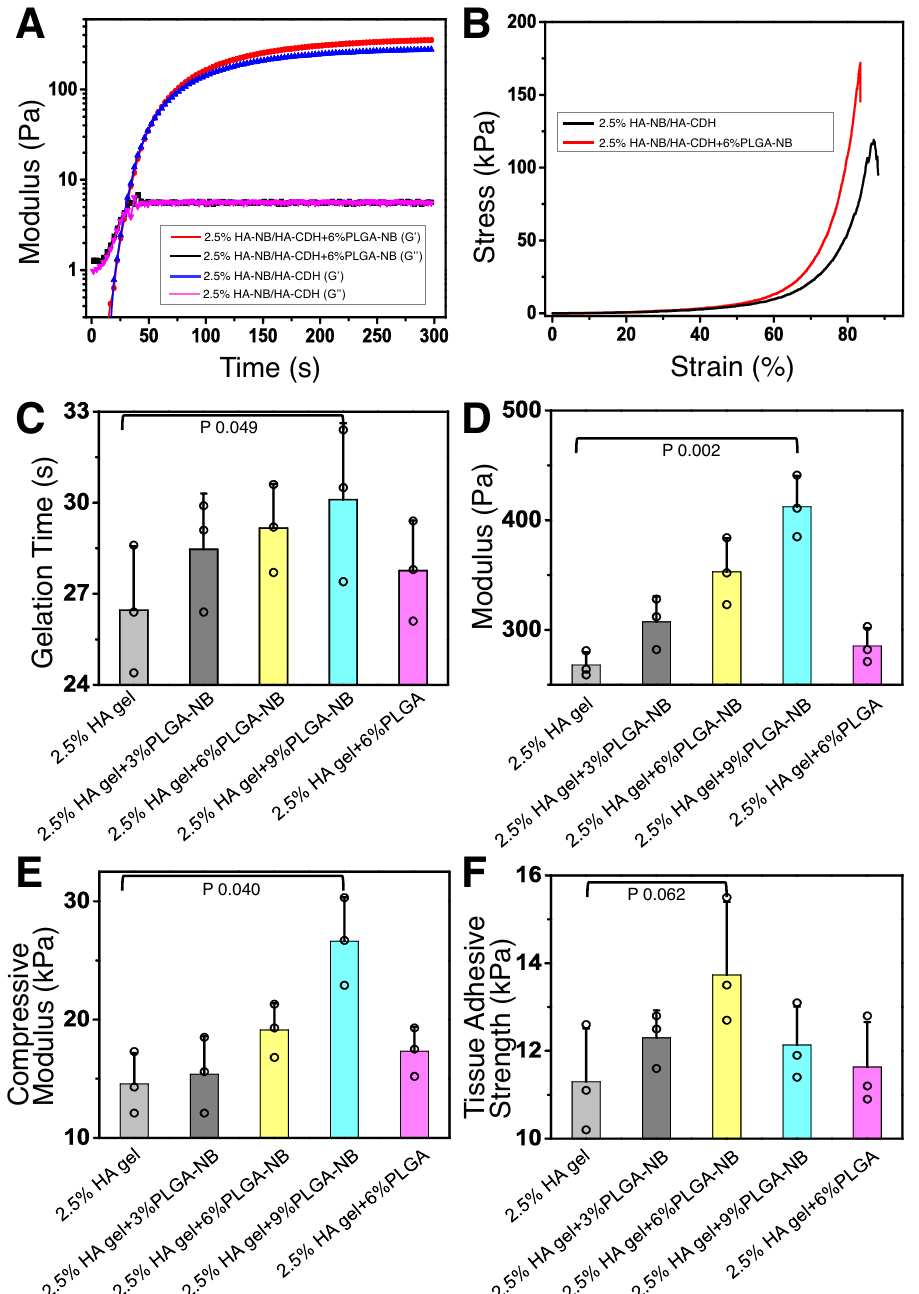
Fig. 3 PLGA-NB capsules can strengthen the photo-crosslinking hydrogel network. A Rheology analysis demonstrates the hydrogel formation for HA- NB/HA-CDH hydrogel with or without PLGA-NB capsules. B Stress measurement for HA-NB/HA-CDH hydrogel with or without PLGA-NB capsules. ( C – F ) Gelation time, modulus, compressive modulus, and tissue adhesive strength measurement all demonstrate that PLGA-NB capsules can strengthen and enhance the HA-NB/HA-CDH hydrogel. n = 3 independent samples. Data are presented as mean ± SD. All error bars represent SD. p values for representative data are shown (One-tailed paired t-test). Source data are provided as a Source Data fi